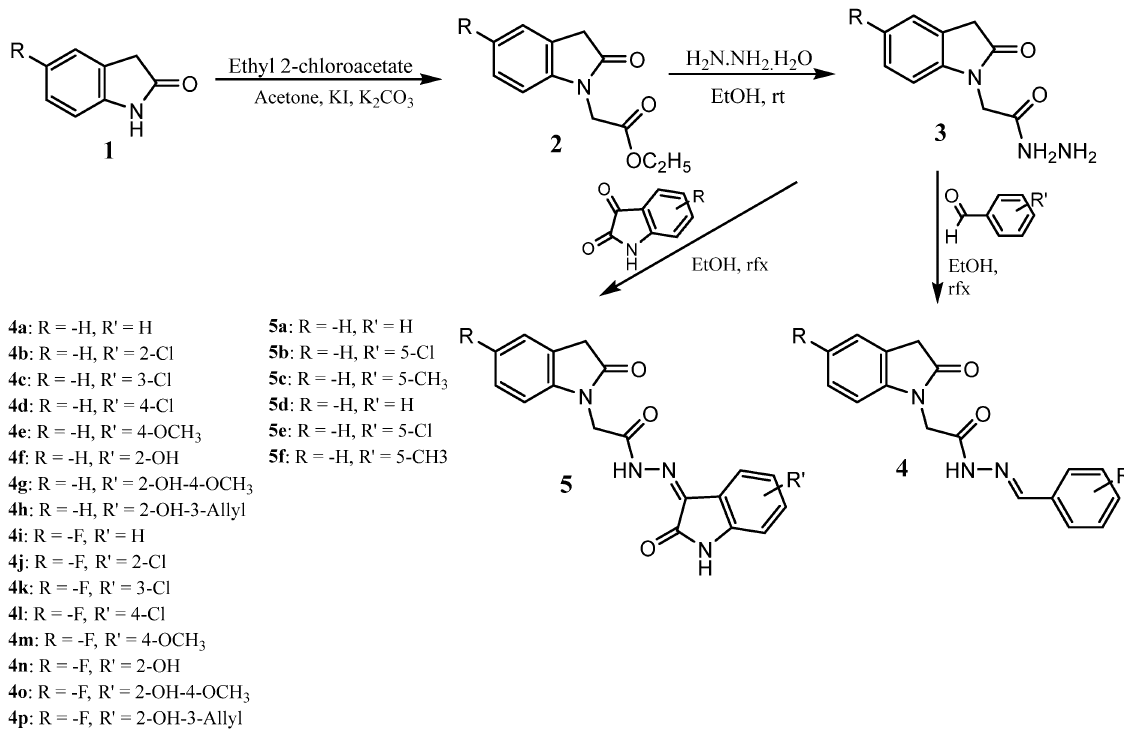
Figure 2. Synthesis of novel 2-oxoindoline-based acetohydrazides ( 4, 5